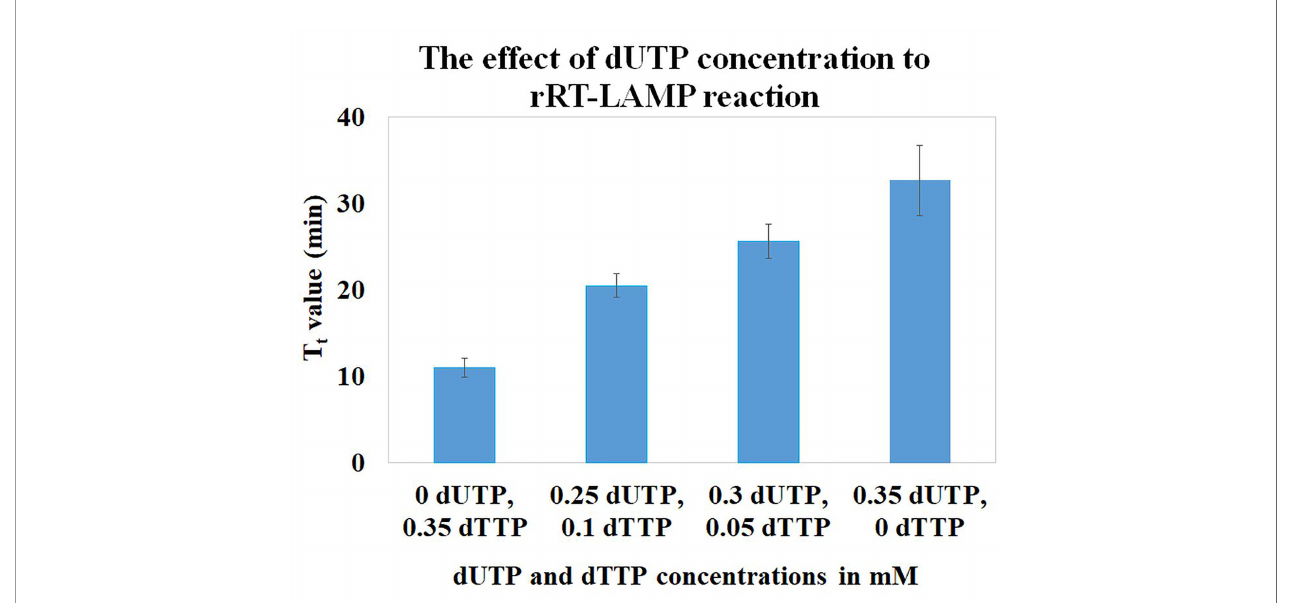
FIGURE 1 | The effect of dUTP concentrations on rRT-LAMP